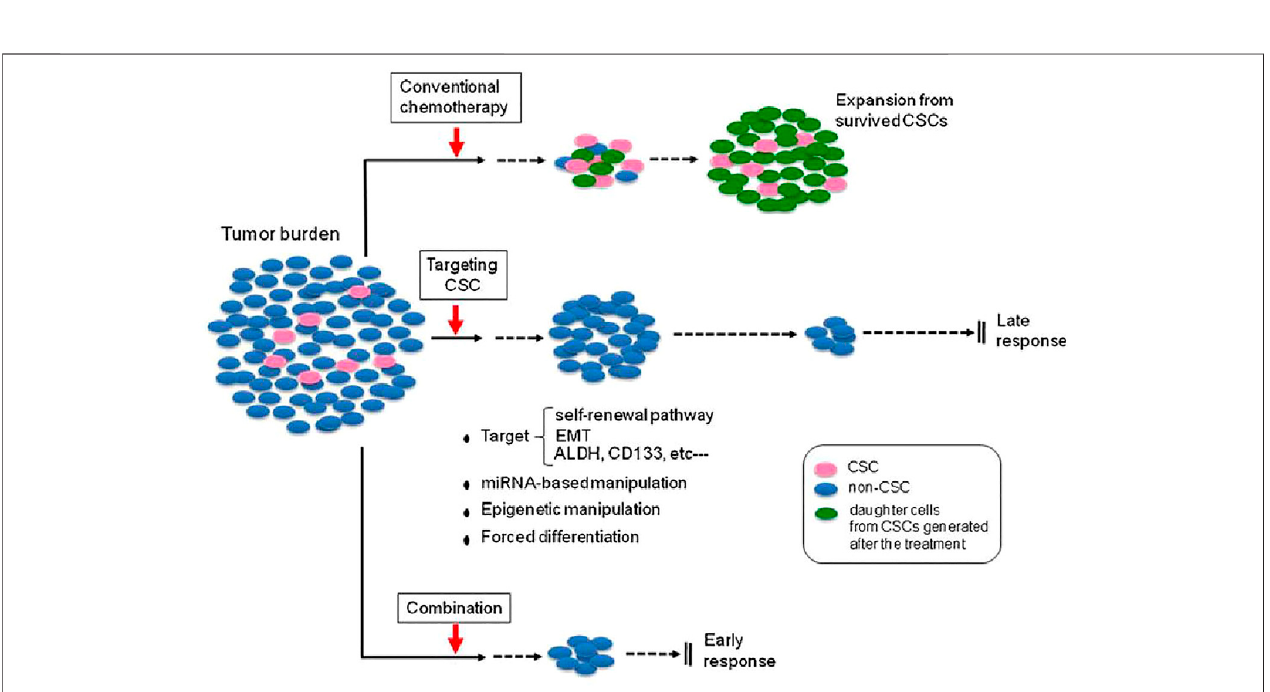
FIGURE 2 | Effectiveness of targeted CSC therapy in combination with conventional chemotherapy. Conventional chemotherapy can decrease tumor size by acting on non-CSC tumor cells; however, tumor recurrence associated with CSCs may lead to treatment failure. Targeting the CSCs could reduce numbers of CSCs followed by better response of tumors to therapy. (The fi gure was reprinted from Kyo ’ s (2013) study.)